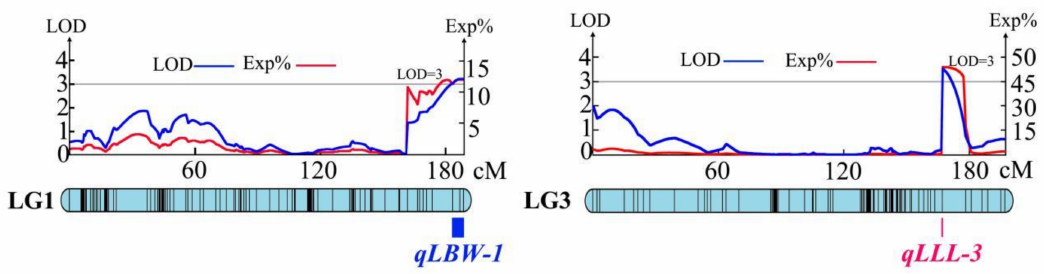
Figure 6. The major QTLs test for leaf traits. LBW: Leaf blade width; LLL: leaf lobe length. The complete description as in Figure